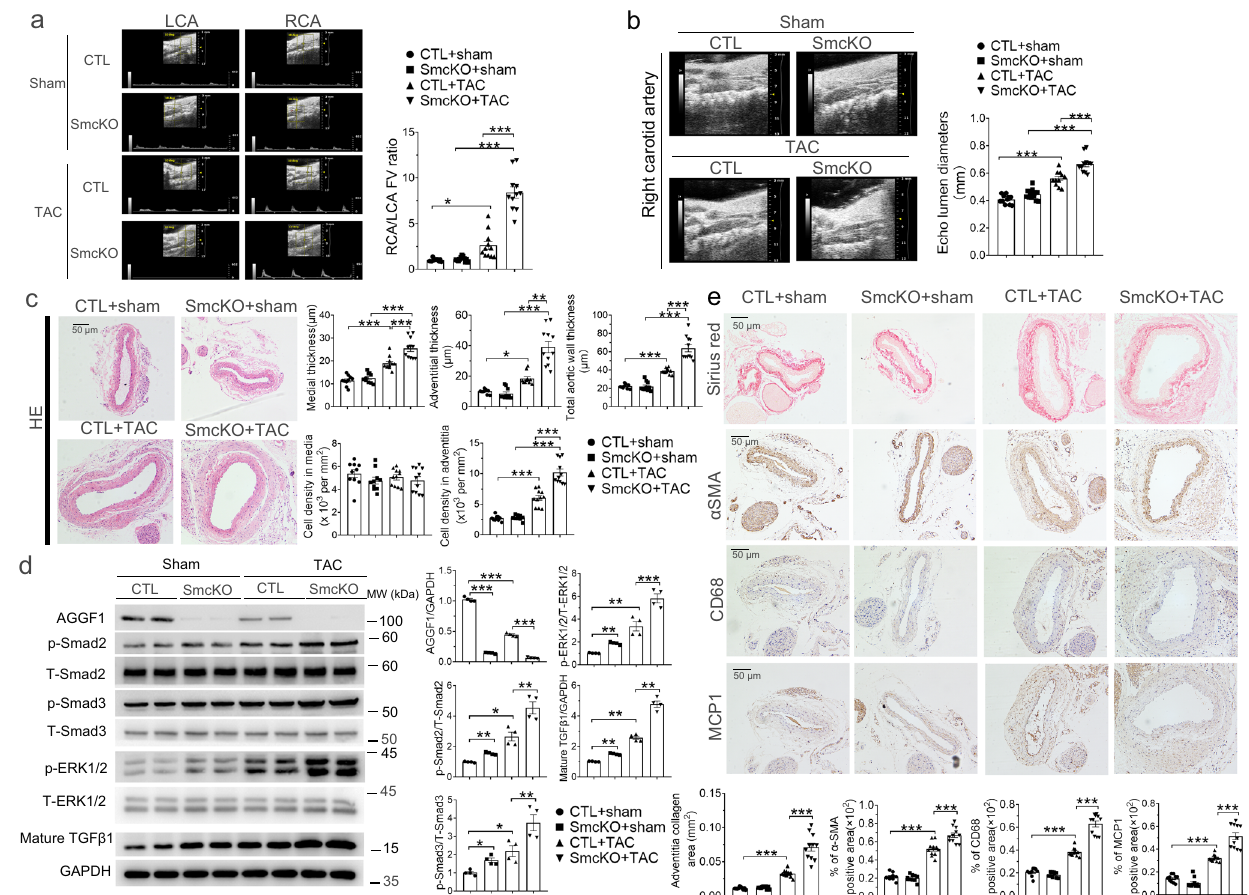
Fig. 2 | VSMC KO of Aggf1 aggravates TAC-induced arterial dilatation, remo-